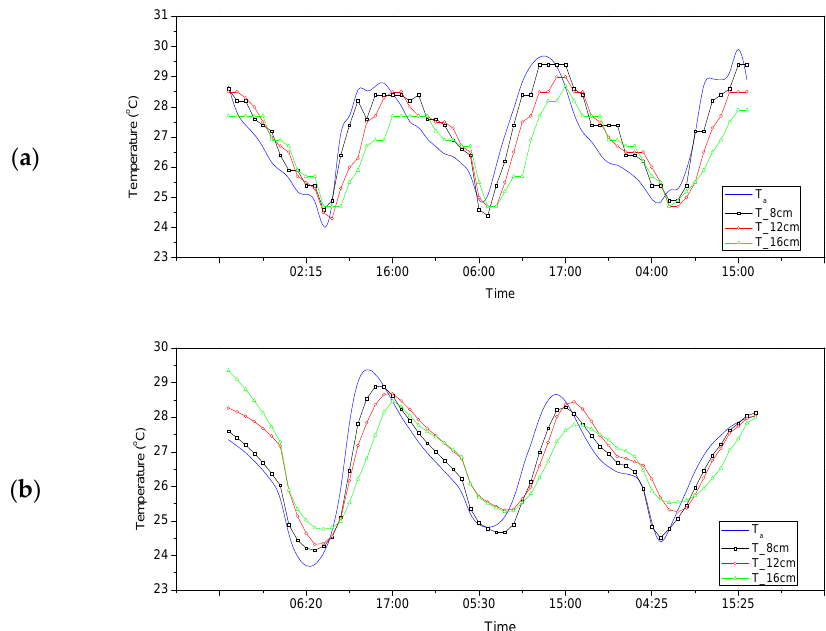
Figure 5. Illustration of the normal air temperature profile and dynamics of co_oil’s temperatures, measured from three different cells of 8 cm, 12 cm, and 16 cm for ( a ) first set, and ( b ) second set of experiments; each set of data were performed for three days.